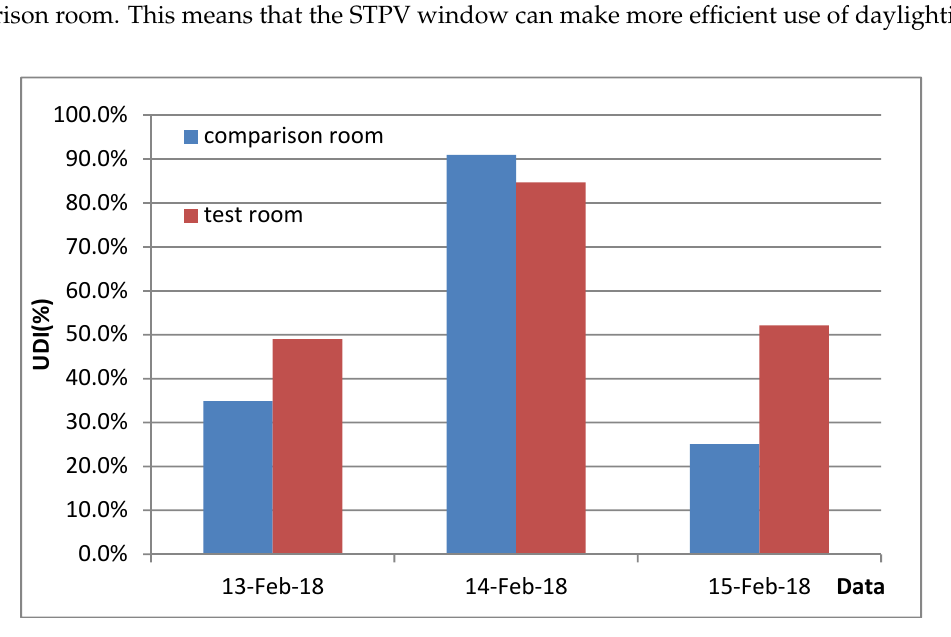
Figure 15. The UDI of those three days.